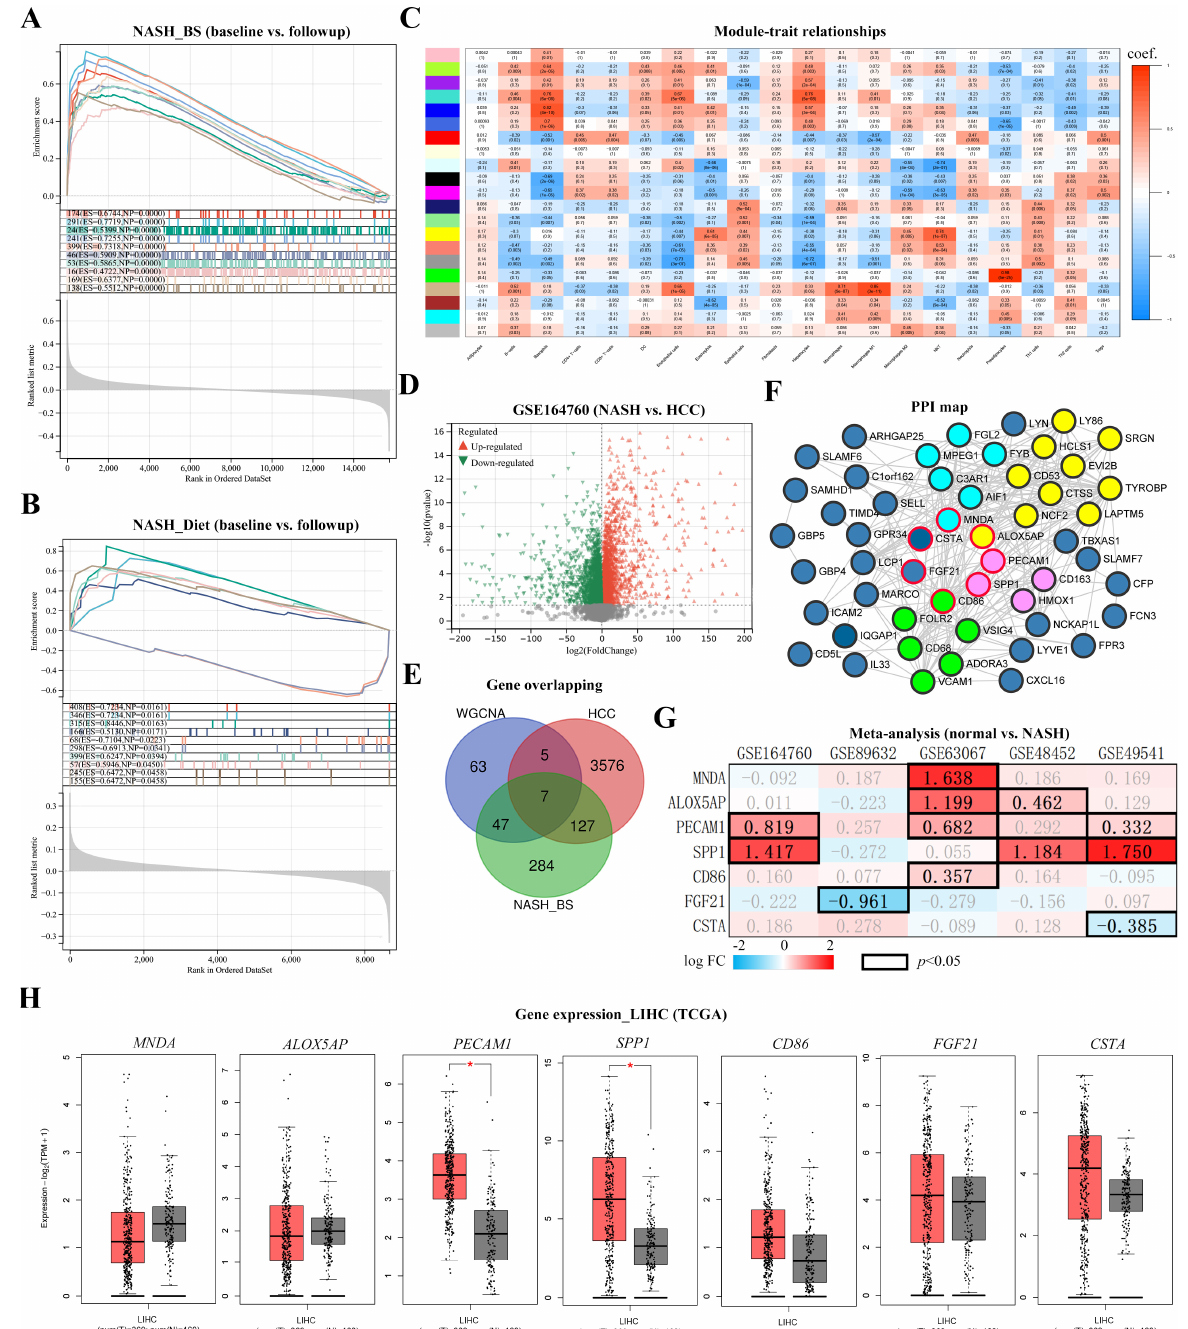
Figure 4. Identification of cancer ‐ associated key genes in NASH_BS livers. Enriched cancer modules were assessed and displayed as ( A ) NASH_BS and ( B ) NASH_Diet subgroups. ( C ) High macrophage ‐ associated gene modules in the NASH_BS subgroup were selected according to WGCNA. Coef [p (scientific notation: e.g. 2e ‐ 05 = 2X10 ‐ 5 )] values were indicated in each block. ( D ) DEGs were screened out from GSE164760 (NASH vs. NASH ‐ derived HCC). ( E ) Overlapping genes were generated from downregulated genes in the NASH_BS subgroup, upregulated genes in the NASH ‐ HCC group, and macrophage associated WGCNA module. ( F ) The PPI network was generated with 54 overlapping genes from downregulated genes in the NASH_BS subgroup and the macrophage ‐ associated WGCNA module. Hub gene clusters were colored light blue, purple, and green. And cancer associated genes were boarded in red. ( G ) Fold changes (FC) of gene ( MNDA , ALOX5AP , PECAM1 , SPP1 , CD86 , FGF21 and CSTA ) expression were meta ‐ analyzed in 5 datasets. FC values